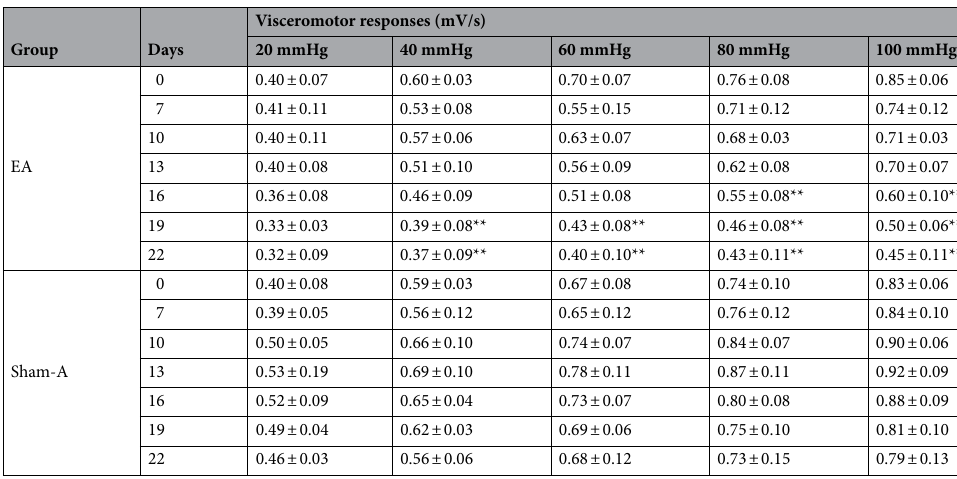
Table 1. Cumulative effects of repetitive EA and Sham-A treatments on VMRs to different CRD pressures (mean ± SD, n = 6). ** P < 0.01, initial VMR values versus VMR values after EA stimulation in EA group. F(6, 35) = 7.613, P = 0.000 for days 19 and 22 with 40 mmHg; F(6, 35) = 6.738 for 22, P = 0.000 for days 19 and 22 with 60 mmHg; F(6, 35) = 12.690, P = 0.000 for days 16, 19 and 22 with 80 mmHg; F(6, 35) = 17.432, P = 0.000 for days 16, 19 and 22 with 100 mmHg. One-way ANOVA is followed by Bonferroni post-hoc